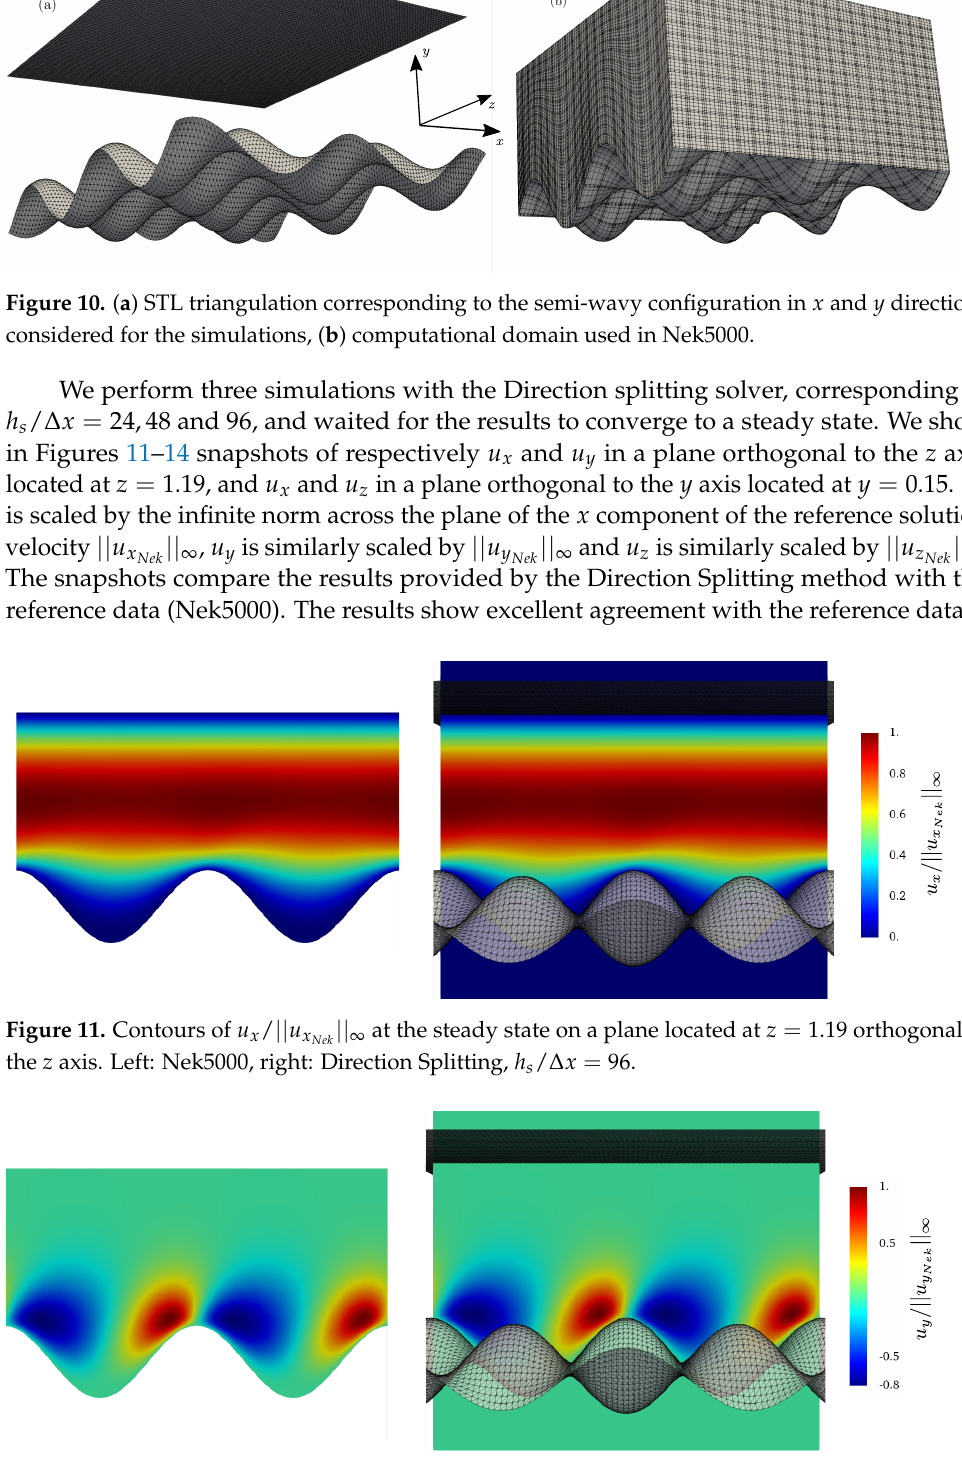
|| ∞ at the steady state on a plane located at y = 0.19 orthogonal to Figure 12. Contours of u y / || u y Nek the z axis. Left: Nek5000, right: Direction Splitting, h s / ∆ x =